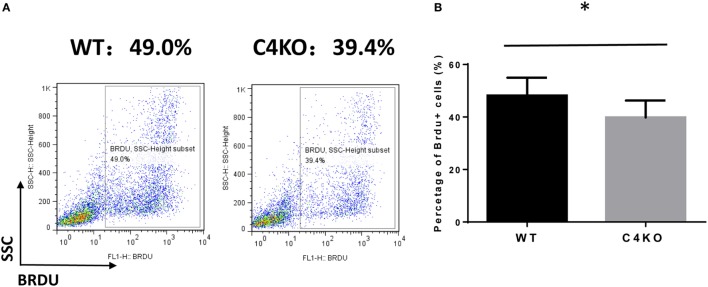
Effect of C4 deficiency on the proliferation of activated T cells. CD4+ T cells purified from naïve wild-type (WT) and C4 KO mice were incubated for 24 h with anti-CD3 and anti-CD28 mAbs and BrdU, then the proliferation of the activated T cells was assessed by estimating the percentage of BrdU+ T cells in the total cells using flow cytometric analysis. (A) Representative results. (B) Summarized results from three independent experiments. Mean ± SEM. *p < 0.05 by paired t-test.